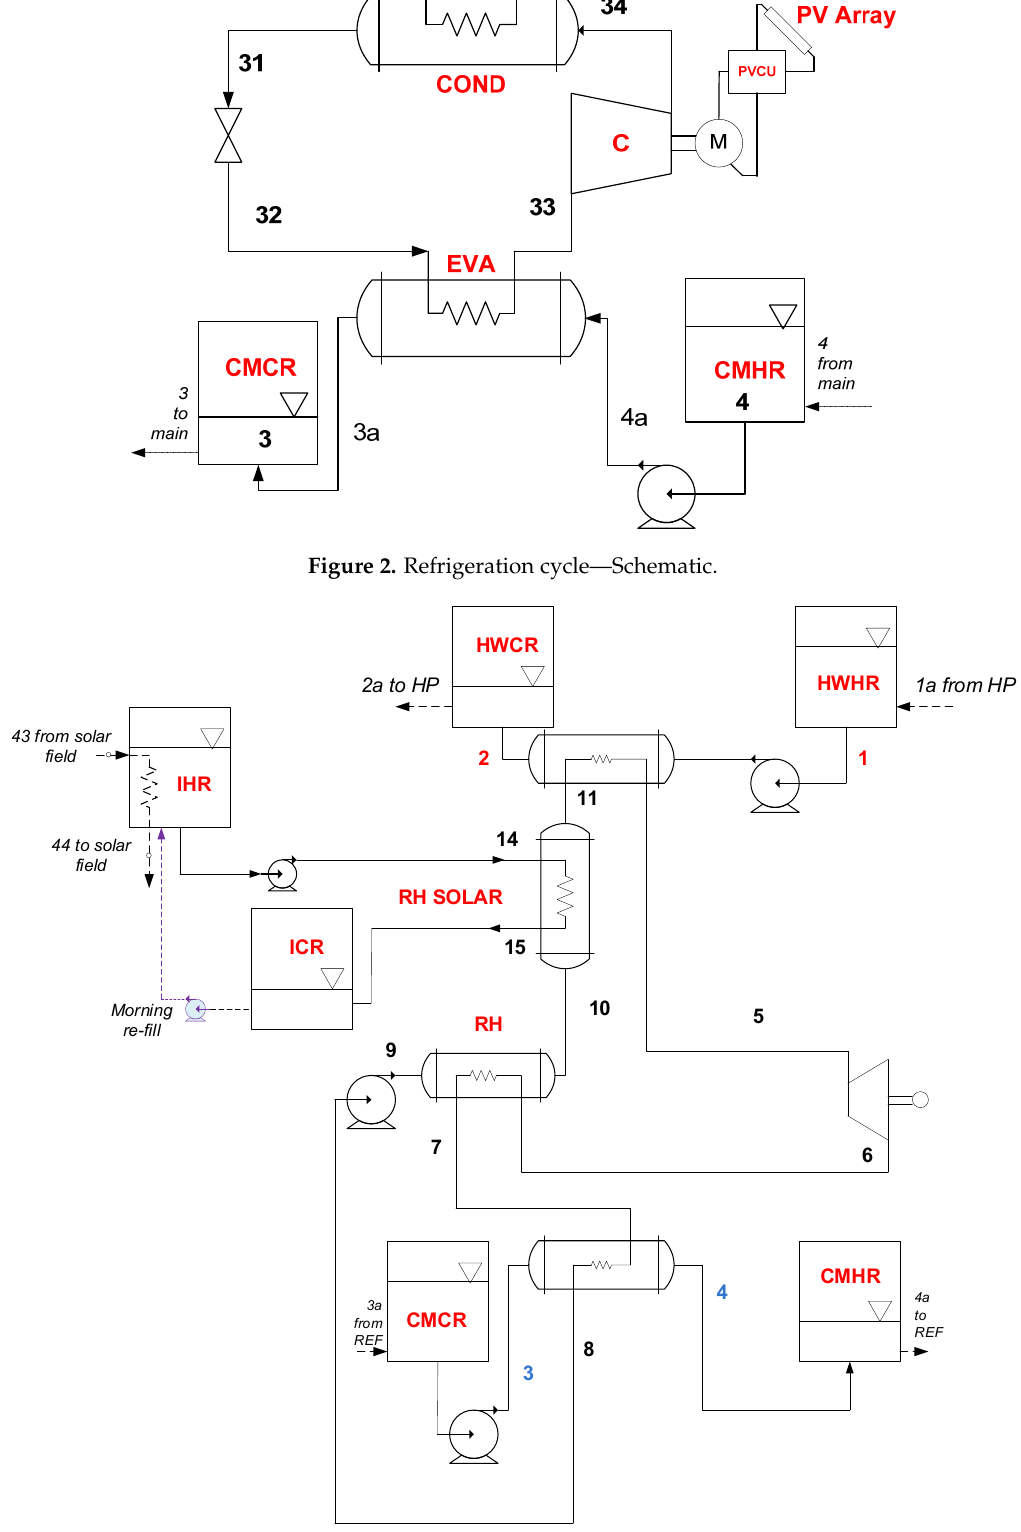
Figure 3. Trans-critical CO 2 power cycle—Schematic.